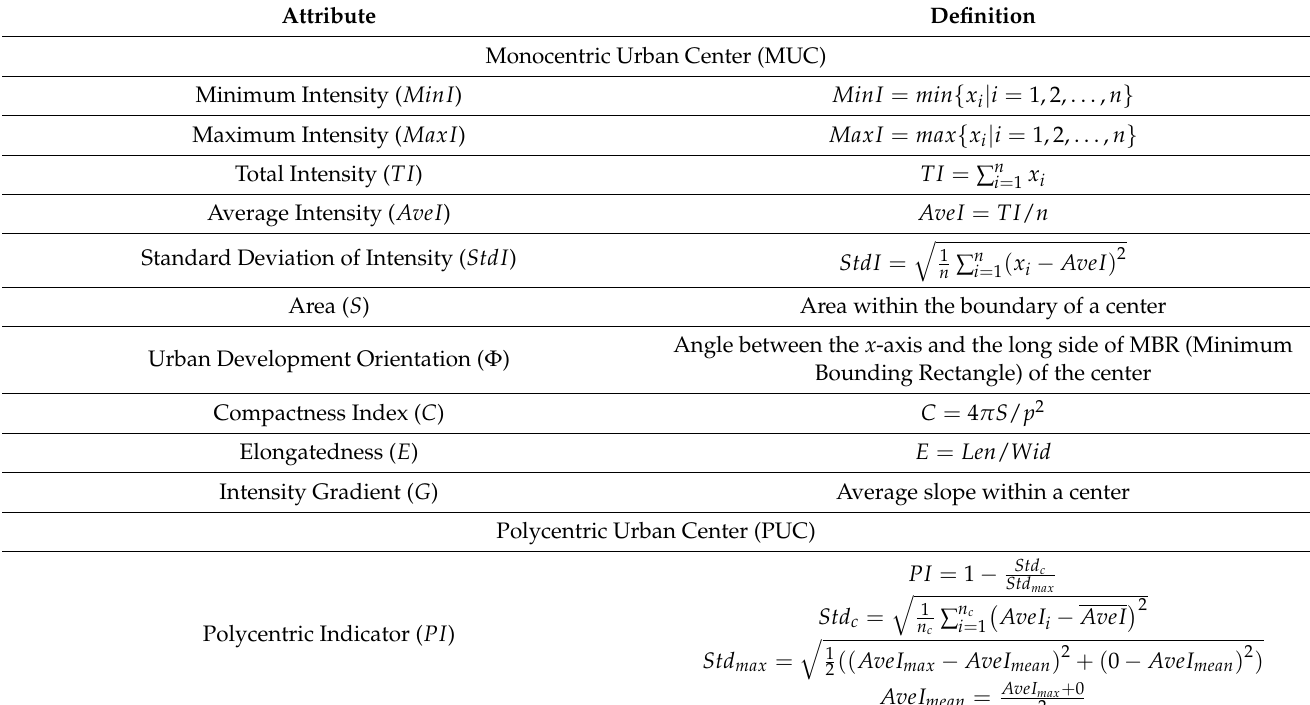
Table 1. Definitions of urban center